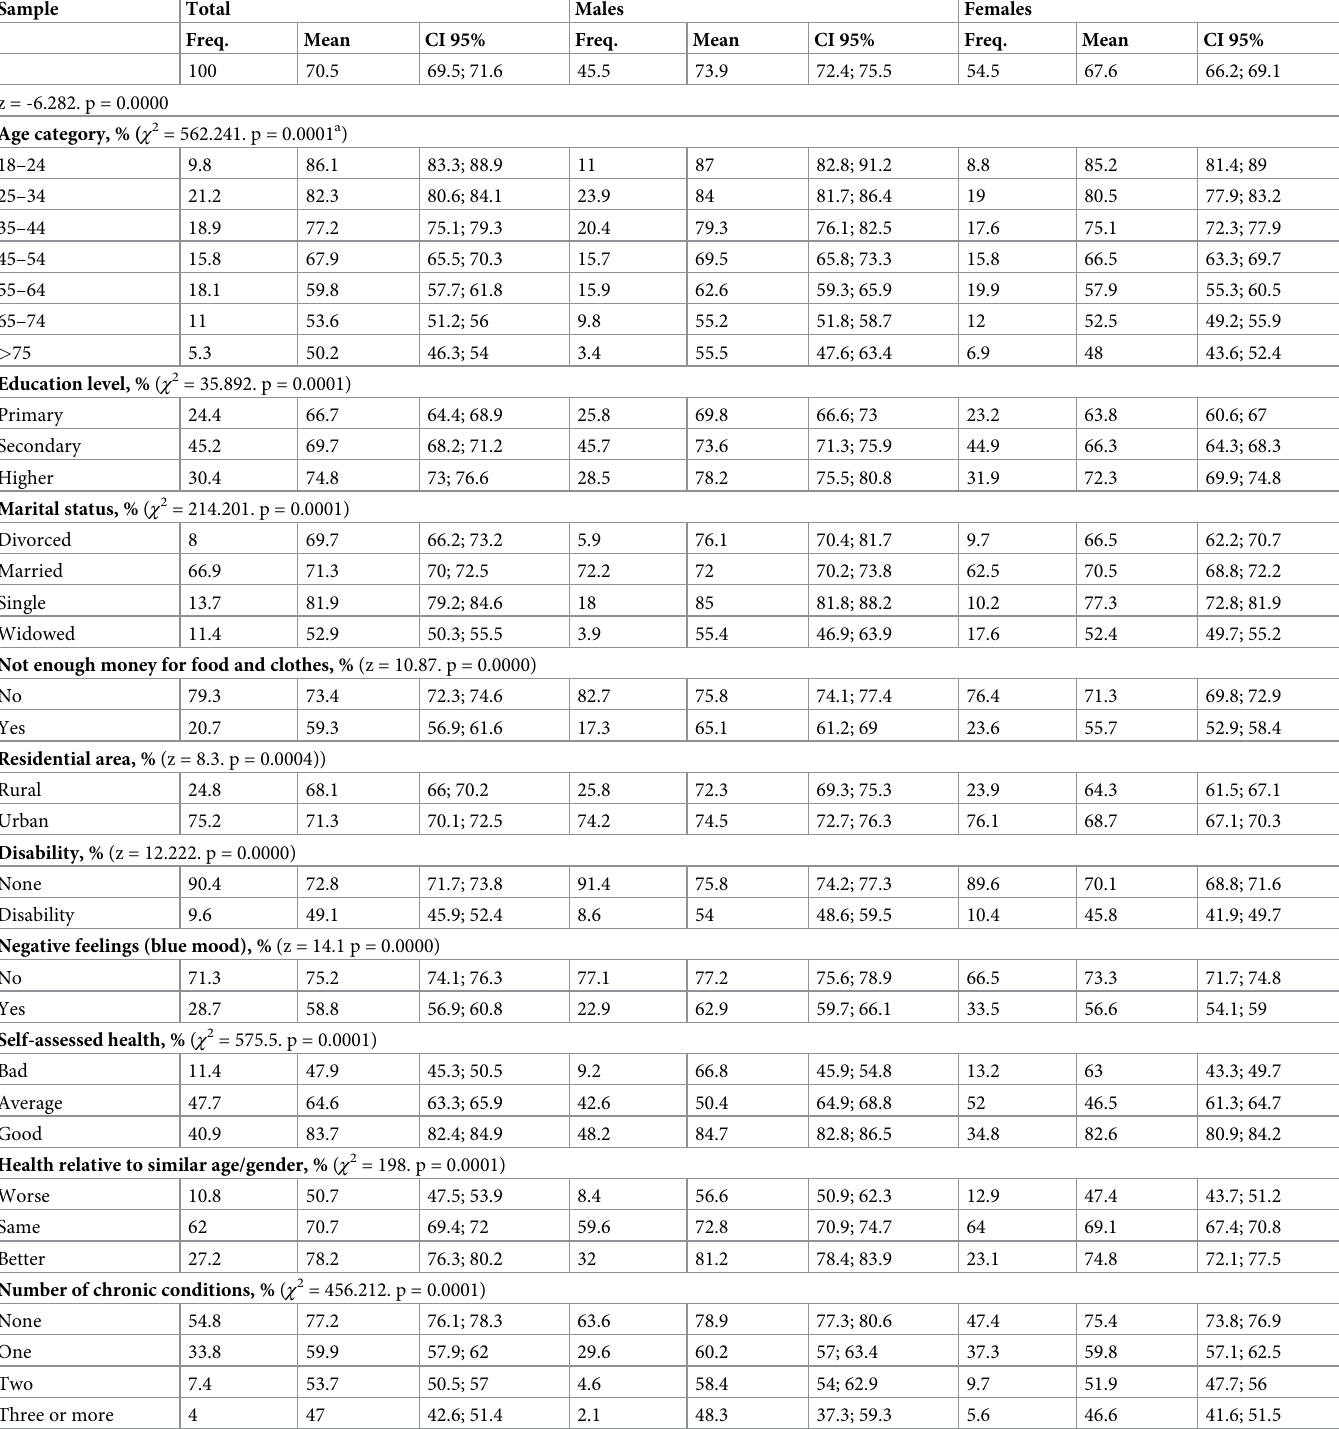
Table 2. Mean EQ-VAS scores by different characteristics.